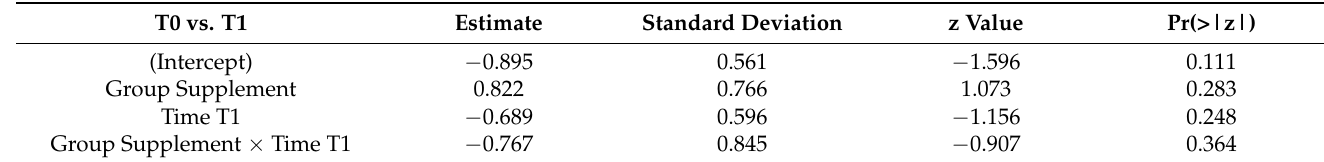
Table 2. Best “Effect” Estimate of Pain with ROM. Fixed effects from multilevel model of pain with ROM at times T0 vs. T1 (Phase 1).